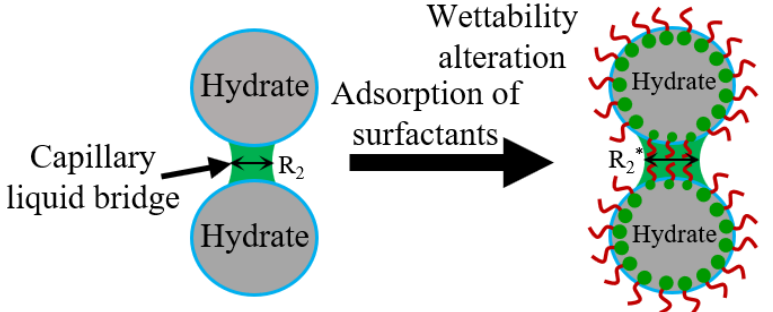
Figure 10. Mechanism of increase in interparticle cohesion by Tween series